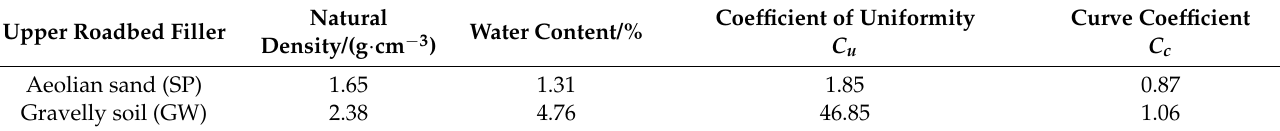
Figure 3. Grading curves of aeolian sand and gravelly soils. Table 1. Physical property index of the upper roadbed filler.